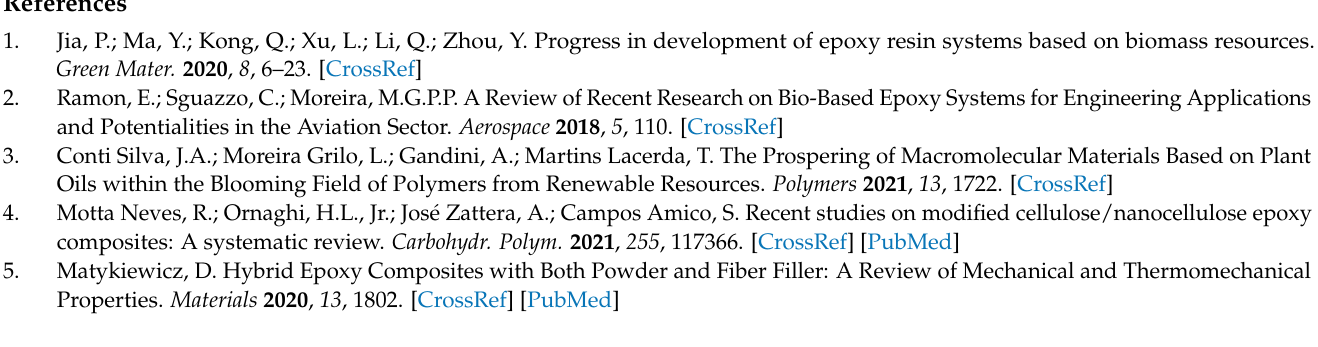
Figure S2—FTIR spectra of crude LO (a) and epoxidized LO (b); Figure S3—Tan delta versus temper- ature registered for the ELO-LnK materials; Figure S4—Qualitative SEM-EDX for Sr sample (SEM at 1000 × magnitude). Insert: quantitative results for ELO-based